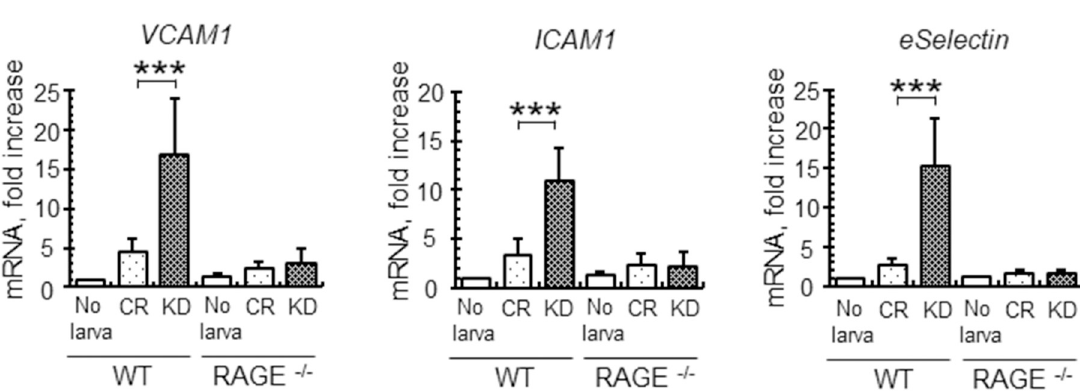
Fig 7. Effects of endogenous venestatin on adhesion molecule production in mouse skin tissues. Quantitative RT-PCR analysis of adhesion molecules from skin tissues of wild-type (WT) or RAGE-null (RAGE -/- ) mice was performed. Total RNA was extracted from mouse skin tissues at the larva inoculation site at 6 h p.i. with 2,000 LL3s treated with ds luciferase (CR) or ds venestatin (KD). The mouse GADPH gene was used to normalize the amount of cDNA, and the expression level in na ï ve skin (no larva) was set as 1. Data are expressed as means ± SDs of three independent experiments with two technical replicates. ��� p < 0.0001.